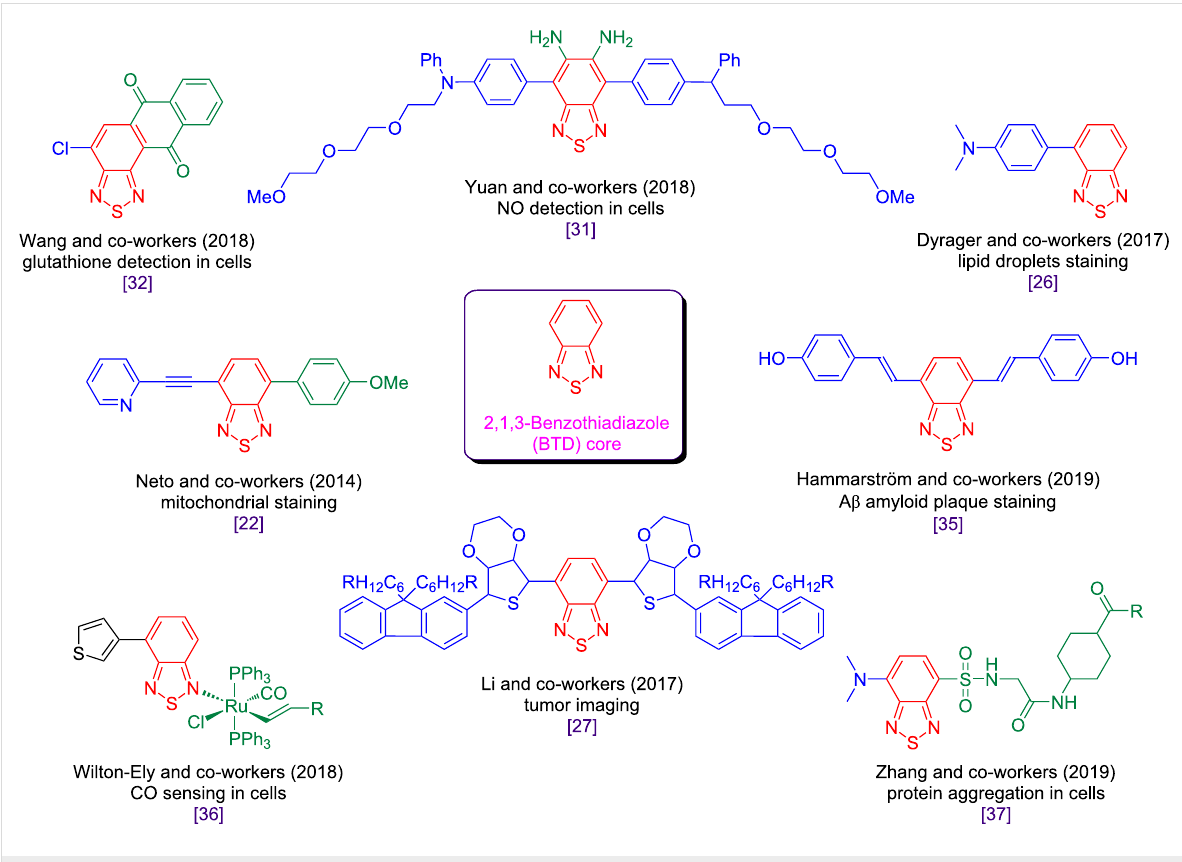
Figure 1: The 2,1,3-benzothiadiazole (BTD) core and its derivatives that are successfully applied in bioimaging